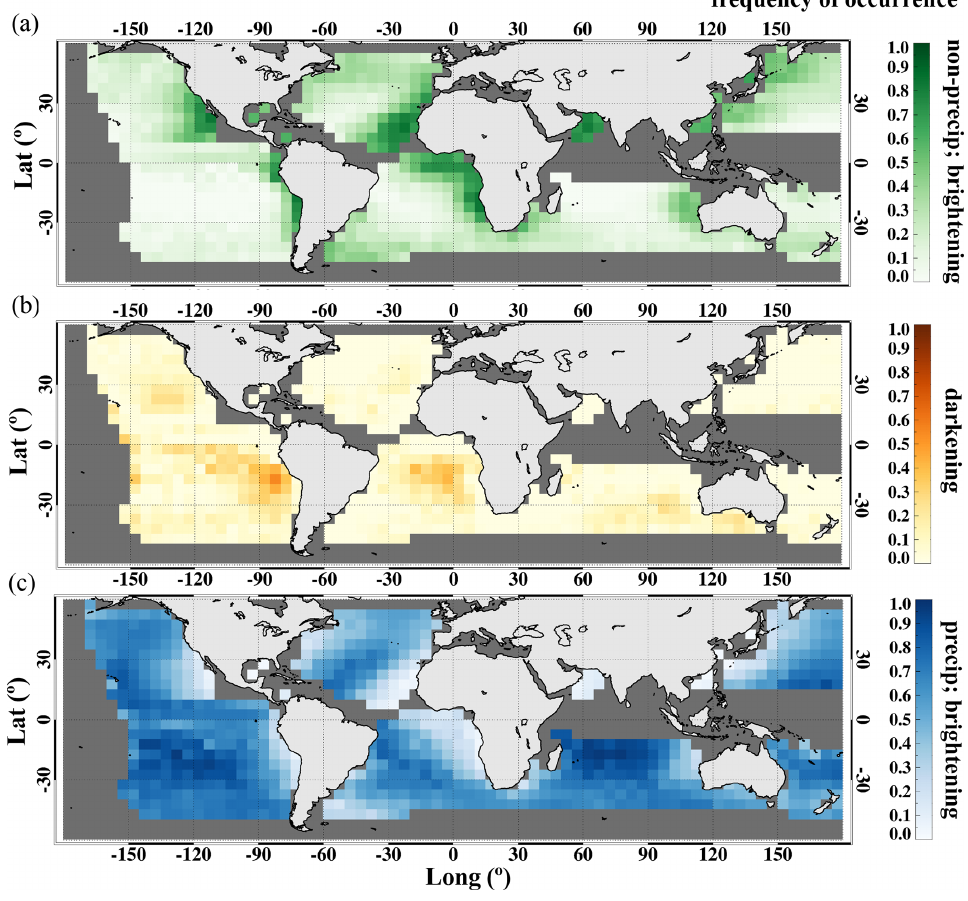
Figure 3. Geographical distribution of the frequency of occurrence of the three susceptibility regimes: (a) non-precipitating–brightening, (b) darkening, and (c) precipitating–brightening. The three regimes are separated based on the sign of S 0 and a r e of 12µm in the LWP– N d variable space for 5 ◦ × 5 ◦ areas, similarly to Zhang et al. (2022). Only areas with an SLLC frequency of occurrence greater than 0.1 are